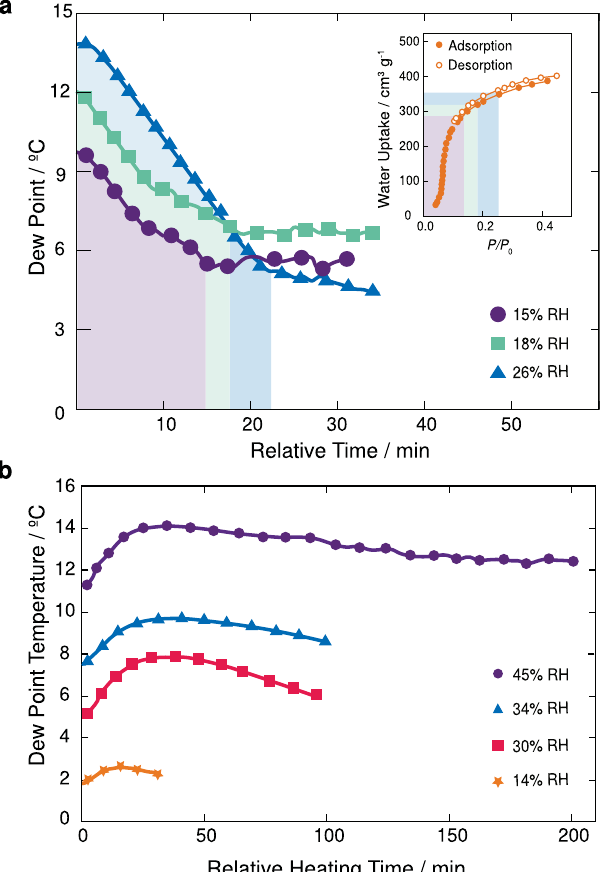
Fig. 3 | Adsorption and desorption phases were used to develop the adaptive WHC algorithm. a The condensation compartment dew point response for the adsorption phase in a WHC. Shown are the relative adsorption time needed for a range of environmental conditions: 15 (purple circles), 18 (green squares) and 26% RH (blue triangles). These adsorption measurements were conducted over a tem- peraturerangeof35 – 40°C.TheinsetisthewatersorptionisothermforMOF-801at 25°C with the water uptake capacity highlighted according to those same envir- onmental conditions. b The desorption phase dew point response as a function of relative heating time recorded in the condensation compartment for various environmental conditions: 14 (orange stars), 30 (pink squares), 34 (blue triangles), and45%RH(purplecircles).Thesedesorptionexperimentswereconductedovera temperature range of 20 – 25°C. Source data are provided as a Source Data fi le.